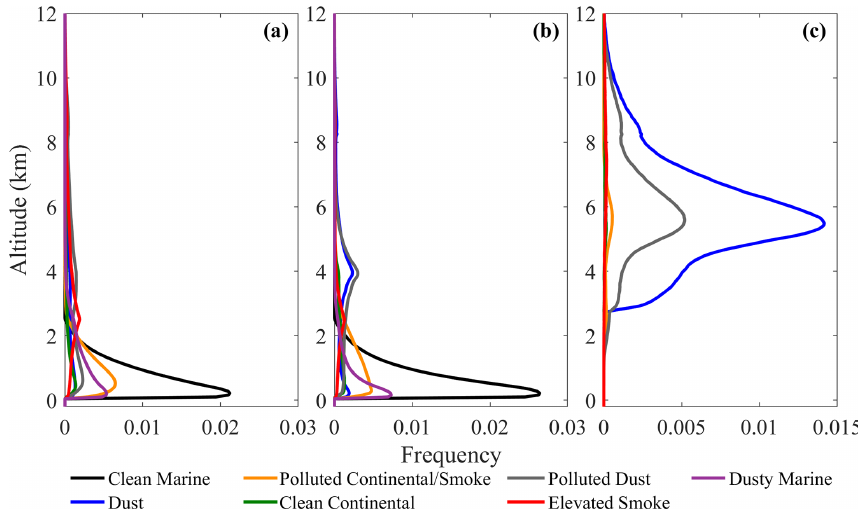
Figure 7. The vertical distribution of multi-year-average (June 2006 to December 2019) OF of aerosol types over the (a) Arctic, (b) Antarctic and (c)